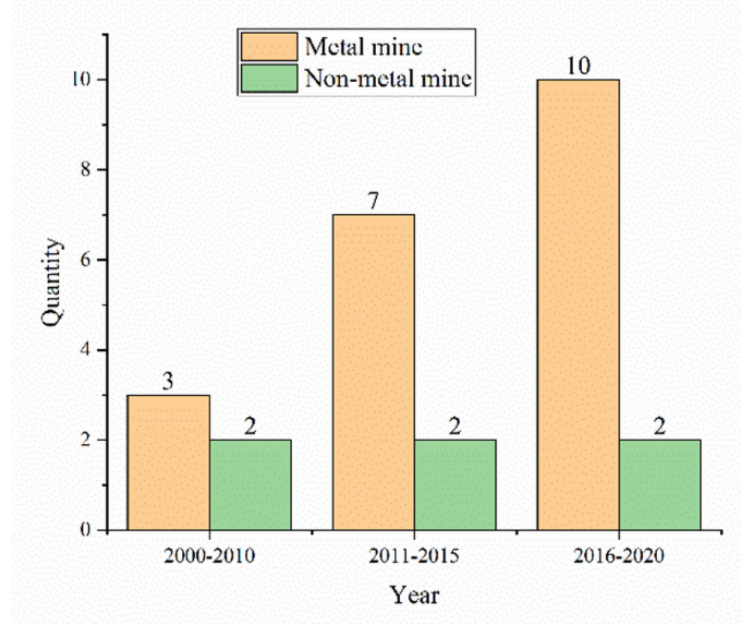
Fig. 1 Metal and non-metal open pit to underground mining research in recent